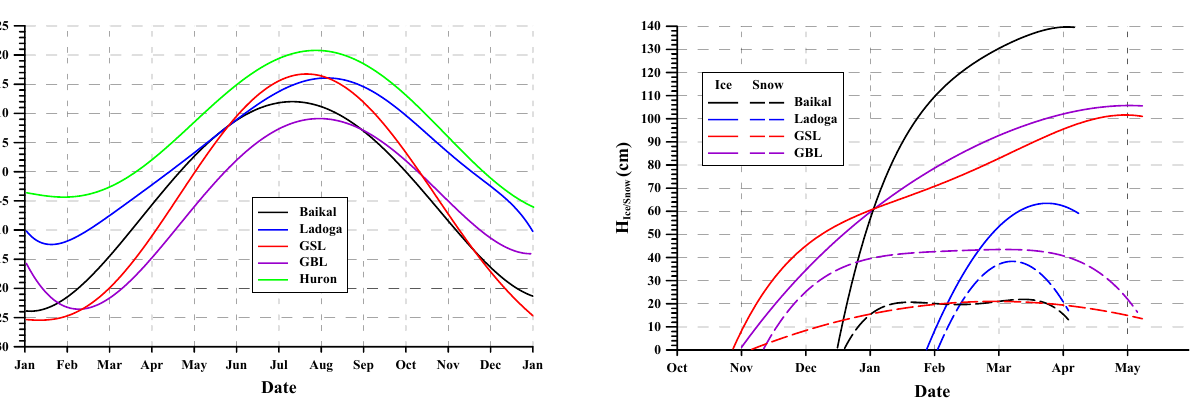
Figure 4. Seasonal variations of ice thickness up to the maximum value and thickness of snow on